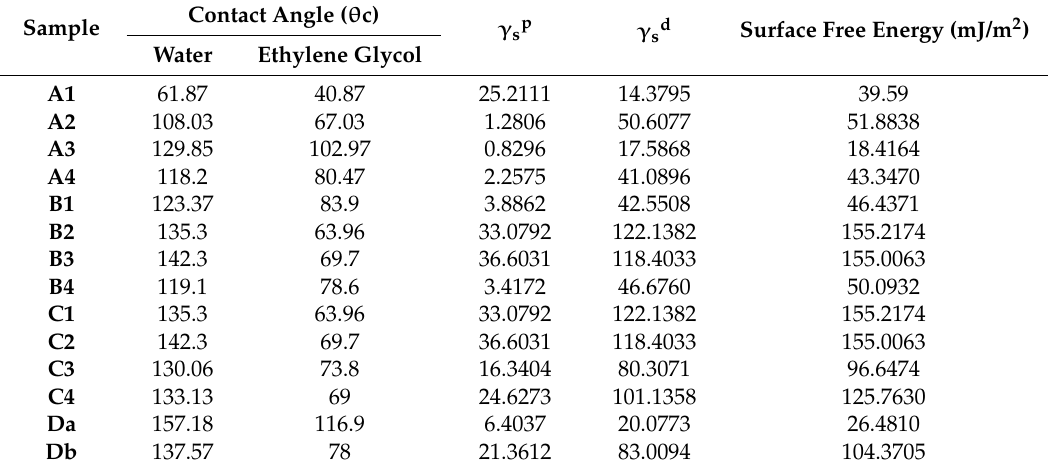
Table 2. Surface free energy calculated from measured contact angle data of thin films deposited on PET